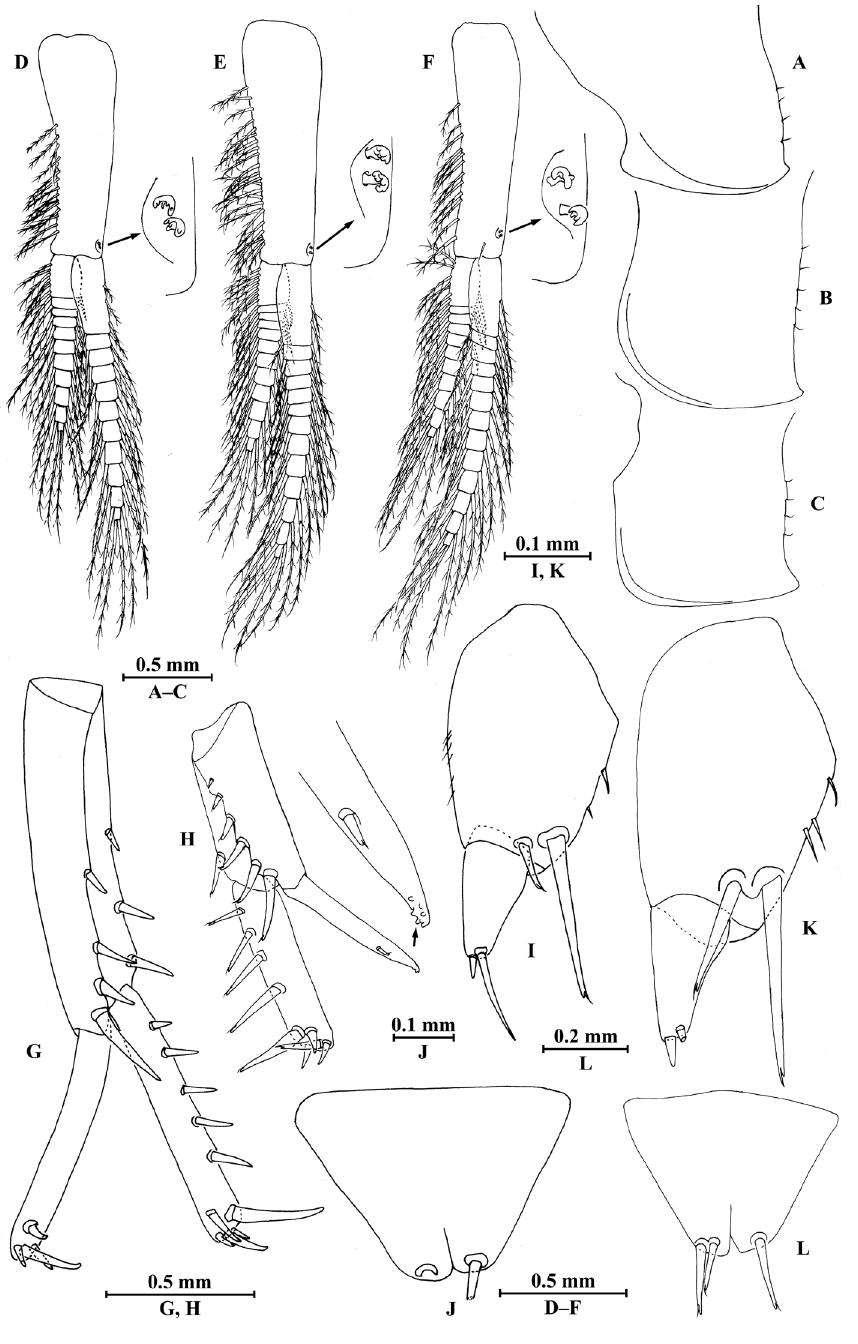
Figure 10. Myanmarorchestia seabri Hou, sp. n., A–J male, holotype; K, L female, paratype. A epimeral plate I B epimeral plate II C epimeral plate III D pleopod I E pleopod II F pleopod III G uropod I H uropod II (right) I uropod III J telson K uropod III L